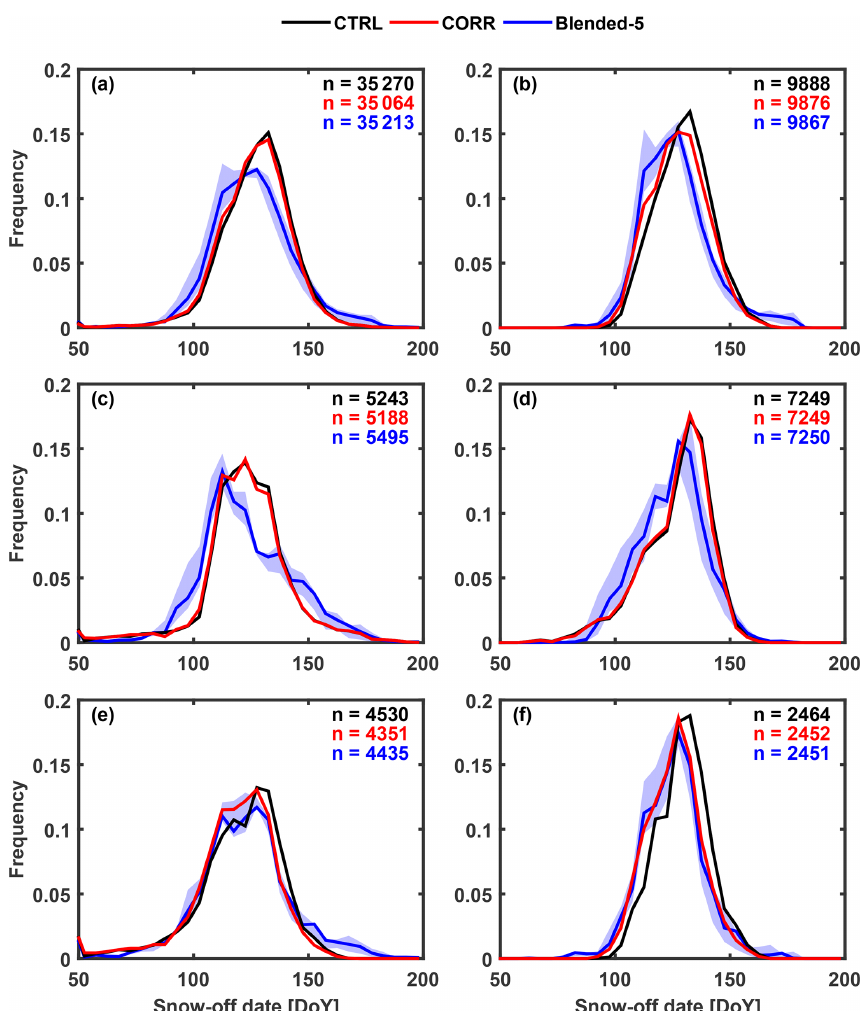
Figure 10. PDFs of snow-off dates and sample sizes n for CTRL (black), CORR (red), and observations (blue) over 1982–2010 across grid cells with coverage by evergreen needleleaf trees of at least 50% and snow cover persisting through December. Observational estimates are shown for SWE thresholds of 1mm (bold line) and 0.5 to 4mm (shaded area). Panels show entire Northern Hemisphere (a) , eastern Europe and western Siberia ( b ; 49 to 66 ◦ N and 29.5 to 90.5 ◦ E), western North America ( c ; 39.5 to 66 ◦ N and 104.5 to 125.5 ◦ W), and eastern Siberia ( d , 44 to 66 ◦ N and 90.5 to 135.5 ◦ E). Panels (e) and (f) are as panels (a) and (b) , respectively, but only for grid cells with average changes in snow-off dates of at least 3d (as seen in Fig.